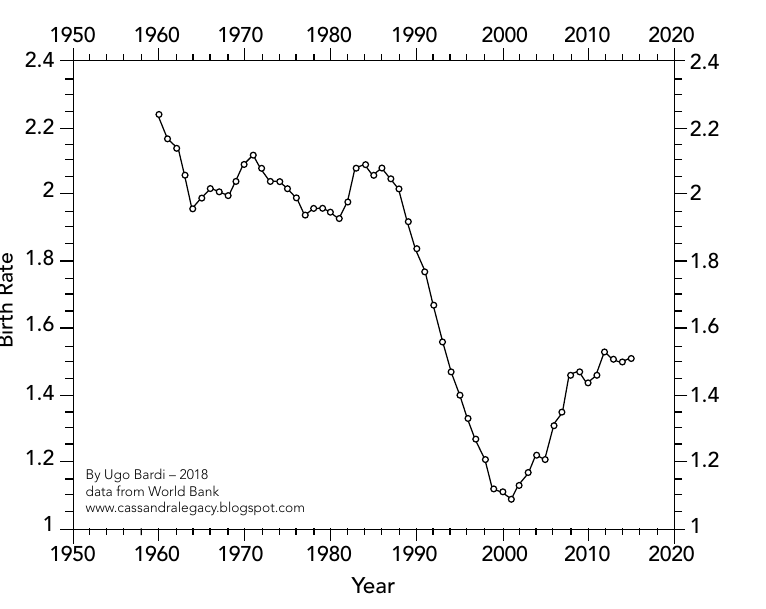
Figure 8 – the crash in birth rates in Ukraine. Data from World Bank. An explanation of why Ukrainian families and Ukrainian women didn’t